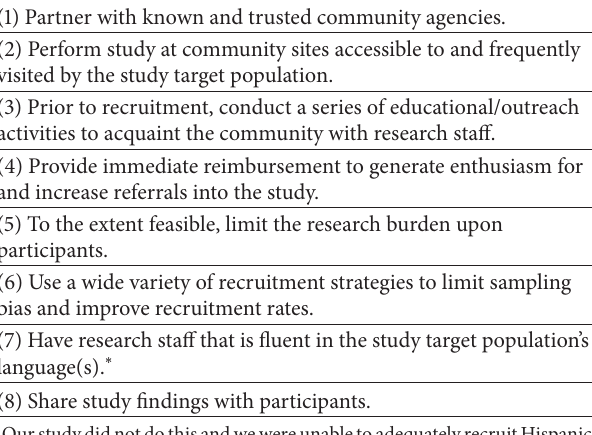
Table 4: Recruitment recommendation